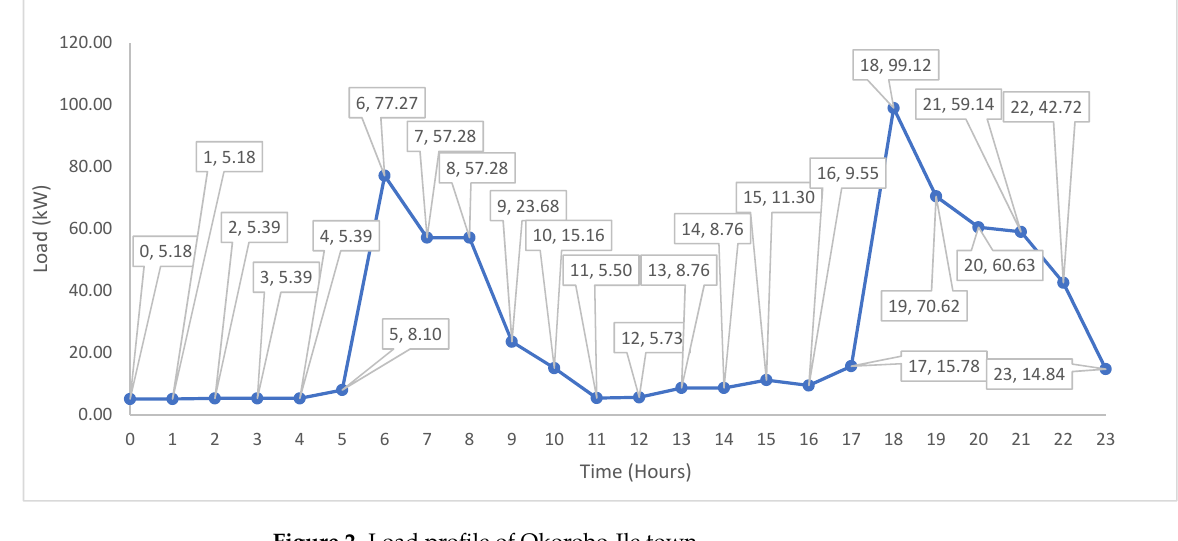
Figure 2. Load profile of Okorobo-Ile town.